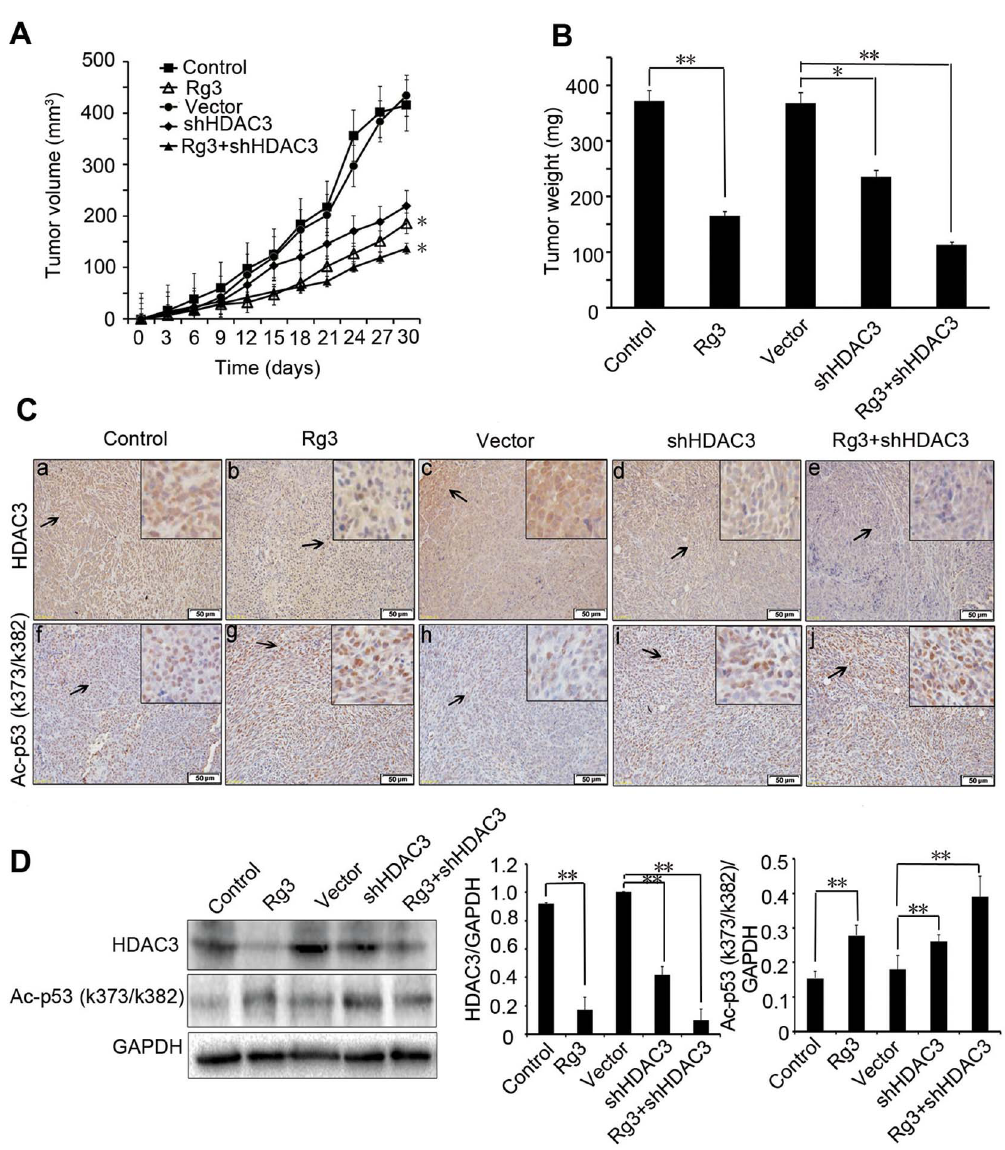
Fig. 7. Rg3 inhibits the growth of melanoma xenograft tumors in vivo . A375 cells xenografted nude mice were injected with vehicle or vector (control), Rg3 (20 mg/kg), shHDAC3 (150 m g DNA/mouse) or Rg3 (20 mg/kg) combined with shHDAC3 (150 m g DNA/mouse). The animal experiment was carried out for 28 days. (A) Tumor volumes after treatment with Rg3, shHDAC3 or in combination with shHDAC3 in xenografts model (n 5 6 per group). (B) Tumor weight. Group data analyses were shown. (C) Immunohistochemical staining of HDAC3 and Ac-p53 (k373/382) expression in xenograft tumor tissues. Bar 5 50 m m (magnification, 6 200). Insets showed enlarged views (magnification, 6 400). (D) Western blotting analysis of expression levels of HDAC3 and Ac-p53 (k373/382) in lysates from the tumors in differently treated mice. GAPDH was used as an internal control. The statistical analyses for Western blotting results were shown. Data were presented as the mean ¡ S.D. of three independent experiments. *, p , 0.05, **, p ,